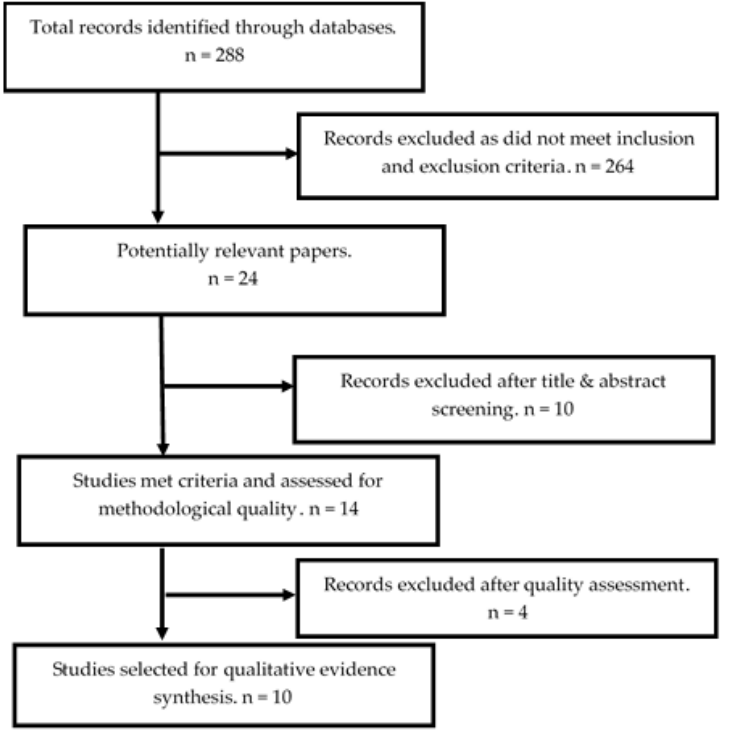
Figure 1. Systematic review flow chart.